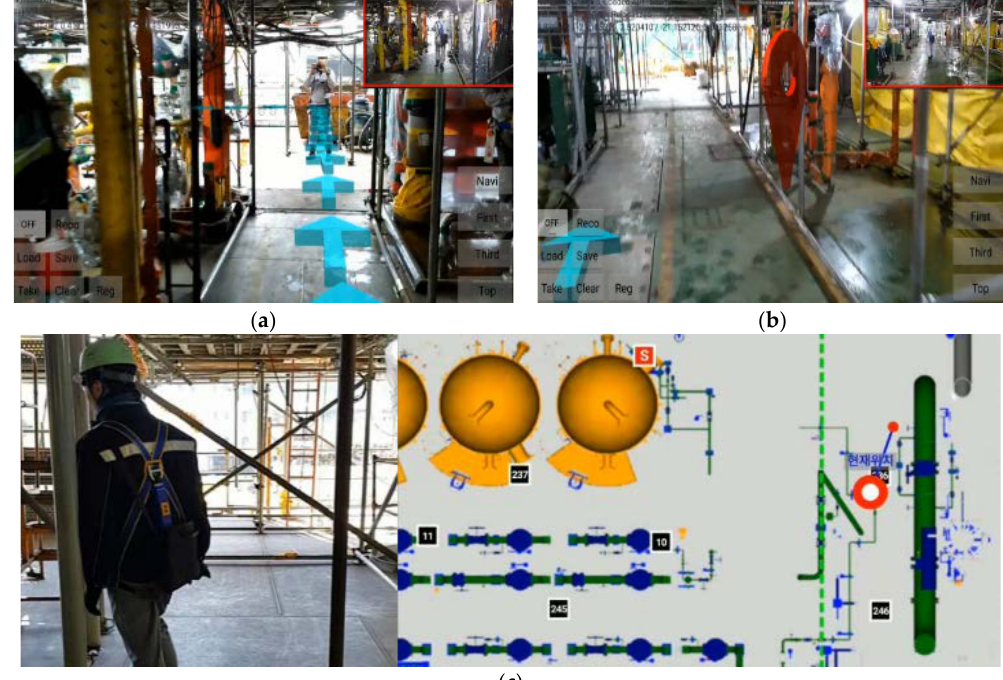
Figure 17. Example of AR-based self-navigation. ( a ) The trajectory route to the destination is represented by AR; ( b ) through the visualization of the pin model, the workers can be aware that they have arrived at the destination; ( c ) the workers can check their location on the map in real time while moving.